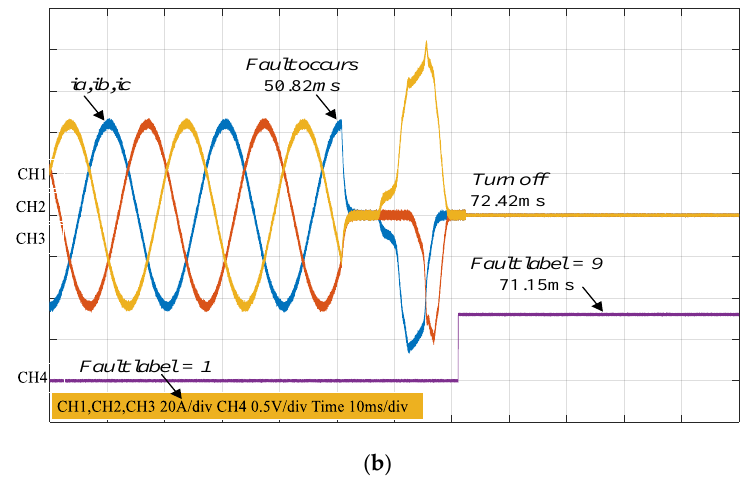
Figure 7. Fault diagnosis results: ( a ) S1 open-circuit faults, ( b ) S1 and S3 open-circuit faults. Figure 7a illustrates the experimental results of S1 open-circuit fault. S1 open-circuit fault occurs at 59.21 ms; the fault diagnosis system detected and located the fault at 79.92 ms, of which the fault label is as shown in Table 1. After detecting the IGBT open-circuit fault, the converter shut down at 82.01 ms to protect the device from secondary failures. Figure 7b illustrates the experimental results of both the S1 and S2 open-circuit fault.